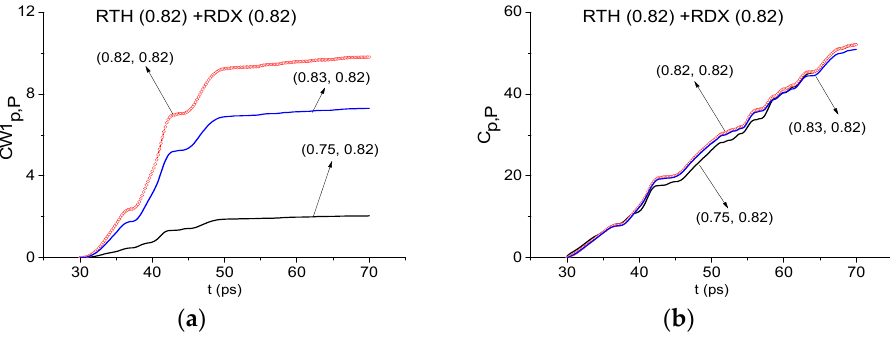
Figure 14. Time-dependent ICCs C CW p , P (a) and C p , P ( b ) computed for the RTH frequency ν = 0.82 THz in the FDR ν = [0.75, 0.83] THz.